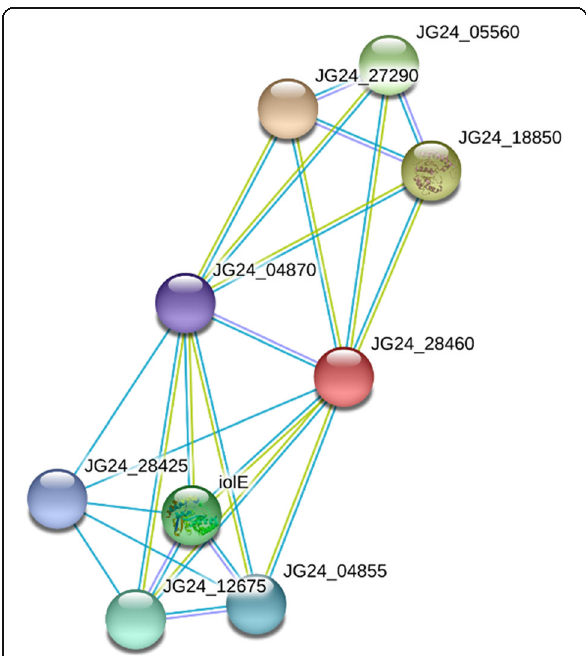
Fig. 3 Protein interaction network of A. EJJ83173 (JG24_28460). The interactions were constructed using the STRING database. Most proteins in the interaction are involved in inositol metabolism, which supports the re-annotation of EJJ83173 as inositol